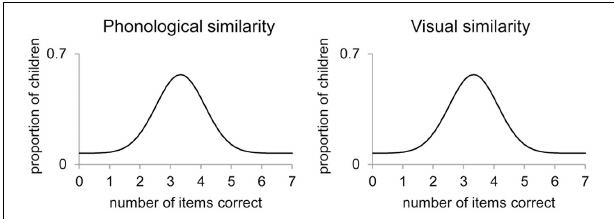
FIGURE 1 | Expected distribution of children (cid:2) s responses when no specific verbal/visual STM processes are used. Legend: The responses of all the children can be summarized by one distribution representing the memory process that is equally affected by phonological and visual similarity.